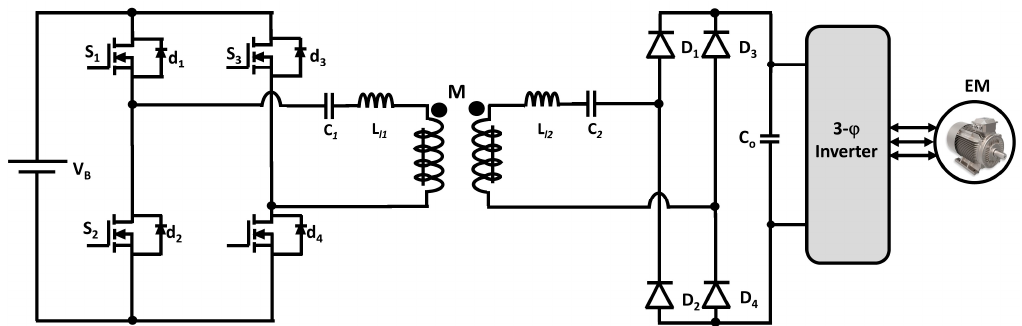
Figure 18. Inductive WPT system with SS compensation topology [141].